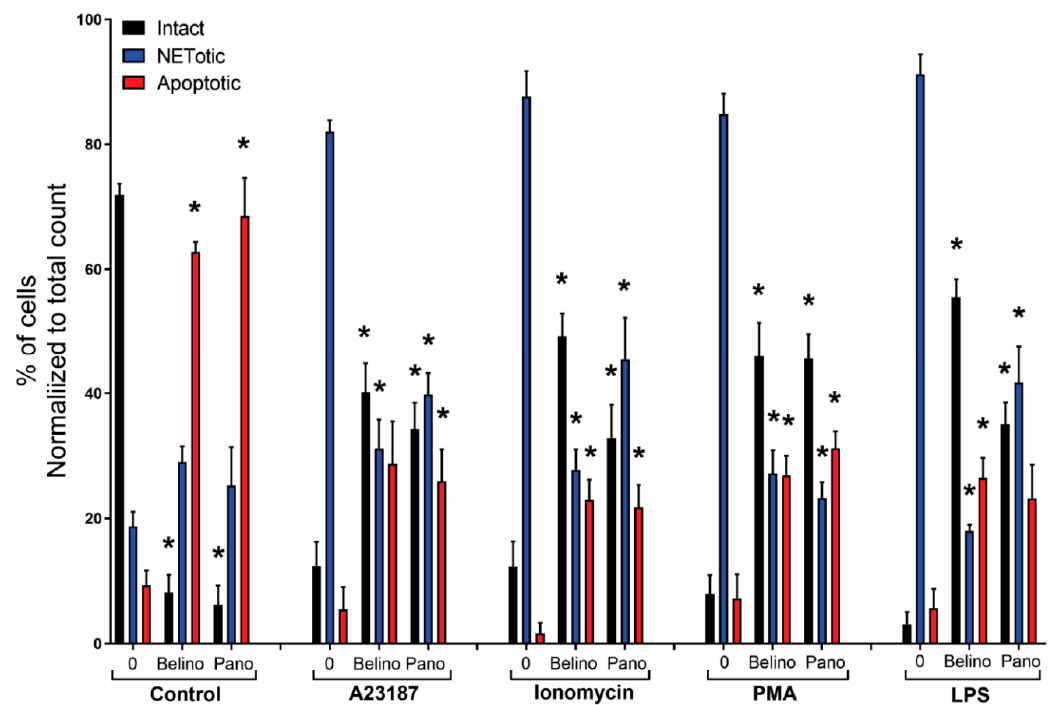
Figure 8. Quantified immunofluorescence images confirm that HDACis promote apoptosis at baseline conditions but prevent neutrophil death in the presence of NETotic agonists. Confocal microscopy images of neutrophils treated with negative control (RPMI), NETotic agonists (25 nM PMA; 4 µM A23187; 5 µg/mL LPS from E. coli 0128; 5 µM ionomycin), and/or HDACis (20 µM belinostat; 3.2 µM panobinostat) for 120 min were quantified by counting cells and results showed that cells treated with HDACis have a significant increase in apoptotic cells but a decrease in the total number of intact neutrophils. Interestingly, cells treated with HDACis in presence of NETotic agonists show a significant increase in intact cells but lower apoptotic and NETotic levels when compared to baseline conditions.